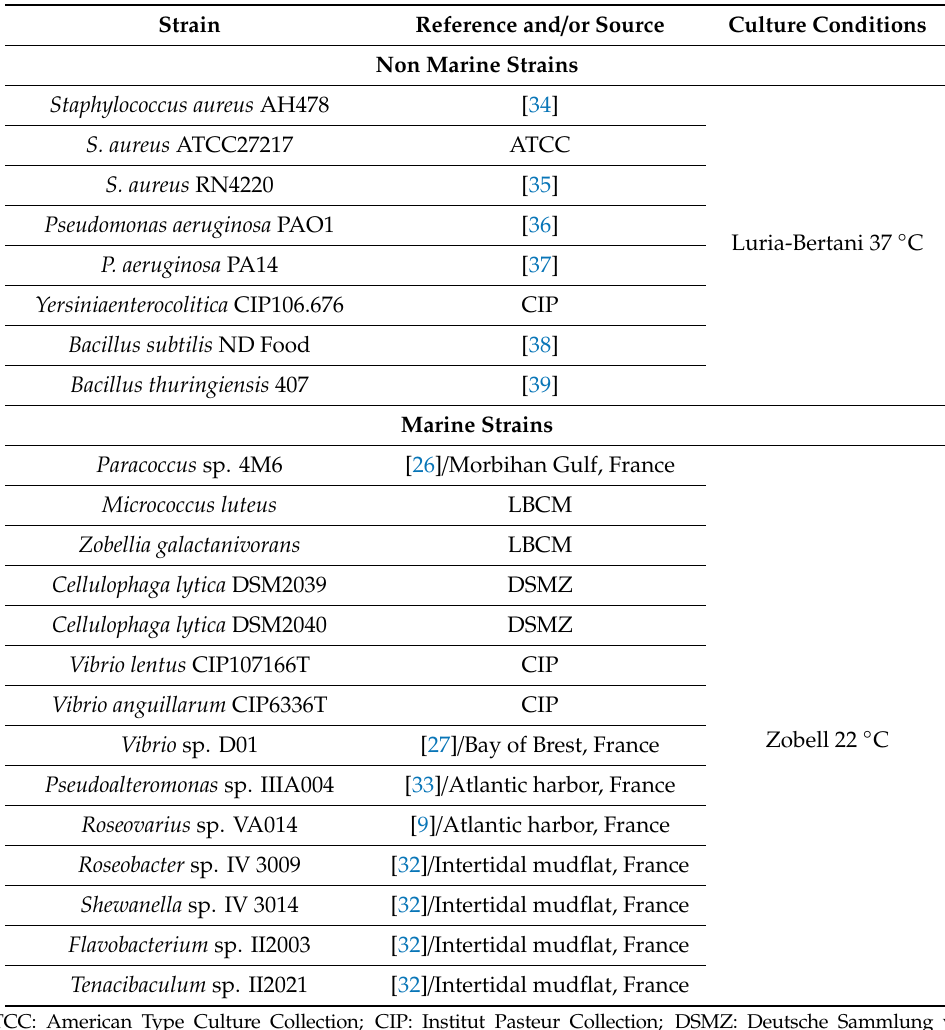
Table 1. Strains used in this